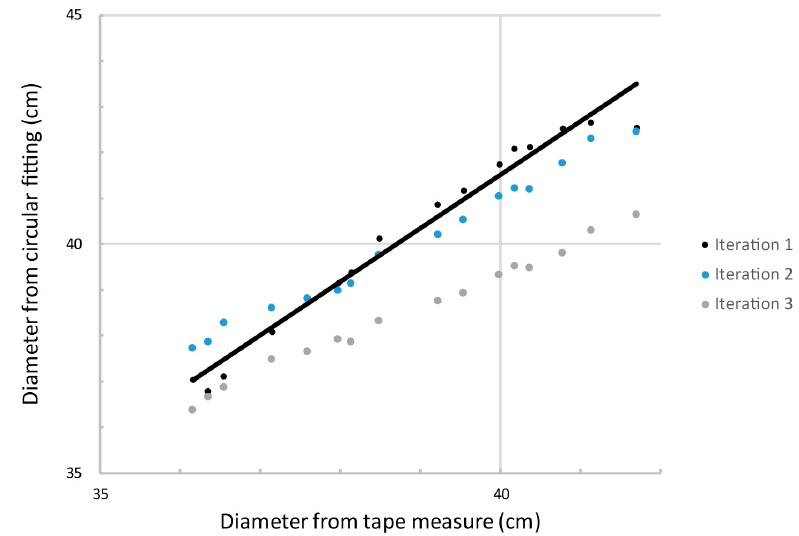
Figure 8. Scatterplot showing the diameter estimations for the same stem from 16 different heights, from three different iterations. In iteration 3, the results are clearly inferior.